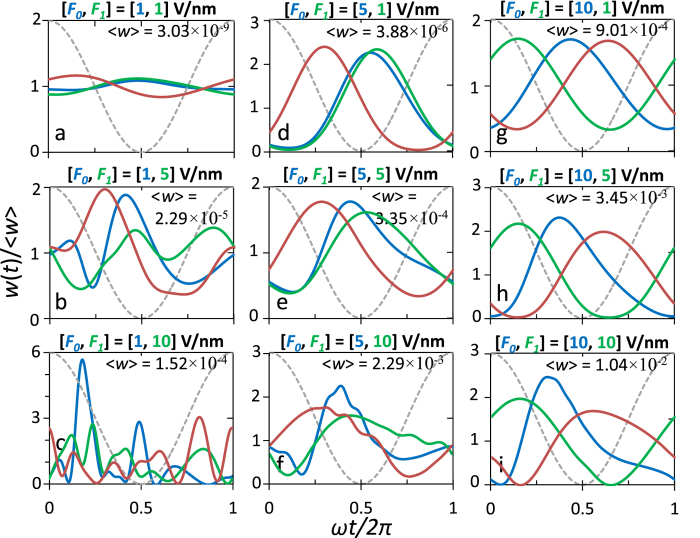
Sample curves in Fig. 4 at  (blue), 100 (green), and 200 (red).Solid lines are the emission current density (or emission rates), and dashed lines indicate the laser field. For the laser electric field F1 = 1, 5, and 10 V/nm, the corresponding laser intensity I = ε0cF12/2 is 1.33 × 1011, 3.33 × 1012 and 1.33 × 1013 W/cm2, respectively.